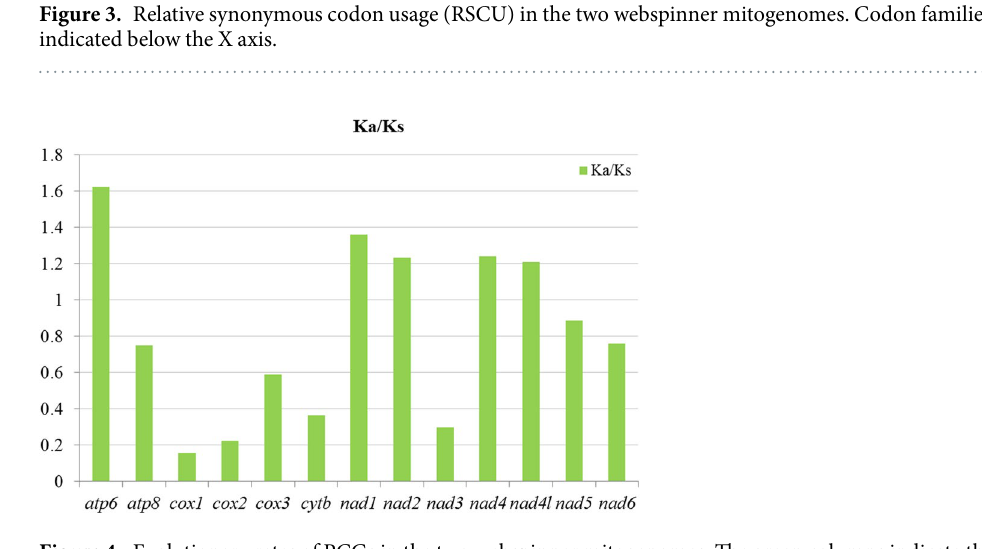
Figure 4. Evolutionary rates of PCGs in the two webspinner mitogenomes. The green columns indicate the average Ka/Ks for each